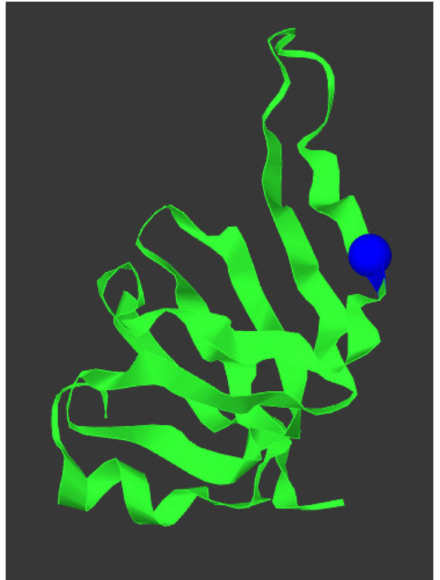
Figure 4. SNRPN protein structure and location p.(Arg65Trp) variant. The protein structure of SNPRN is given in green, the p.(Arg65Trp) variant is depicted as a blue sphere. This figure was generated using mutation3D